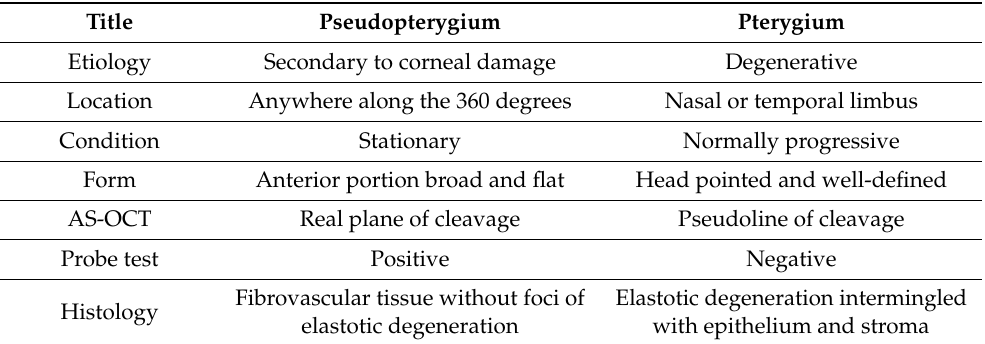
Table 1. Differential diagnosis between pterygium and pseudopterygium. AS: Anterior